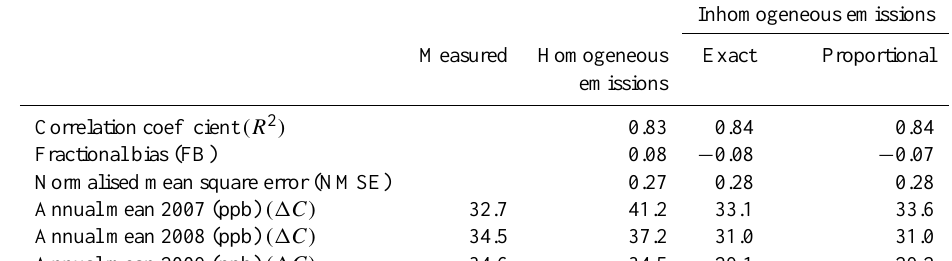
Table 6. Statistical quantities for the south side receptor. Same definitions as in Table 5.